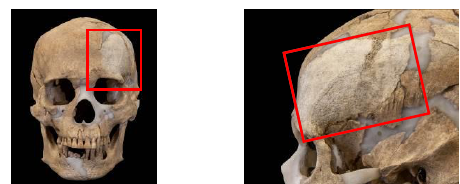
Figuer 5. Left part of frontal bone of skull exposed on shell middens stratum profile (red square)